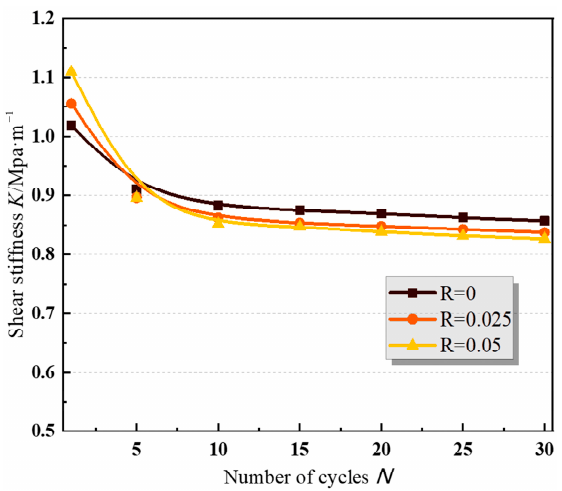
Figure 21. Shear stiffness–cycle number curve under different roughness levels.